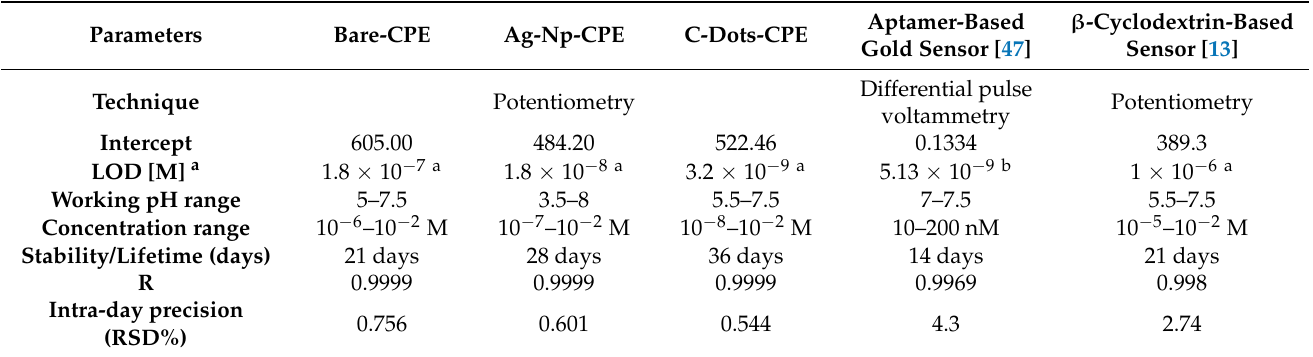
Table 2. Comparison of the sensors prepared in this work with other electrochemical sensors for the determination of TOBRA from